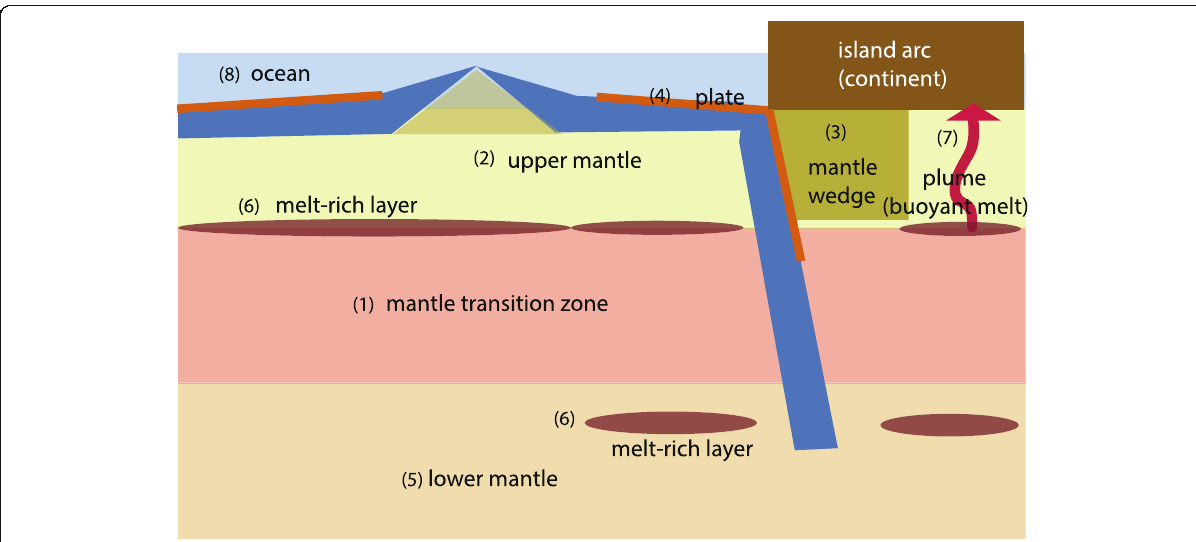
Fig. 1 A cartoon showing the nature of global water circulation. Water is added to the oceans by degassing associated with volcanism. Some surface water goes back to Earth ’ s interior by subduction. A large fraction of subducted water comes back to the surface by arc volcanism. However, water stored in relatively deep portions of a subducting plate survives and is transported to the deep mantle contributing to regassing the mantle transition zone and deeper